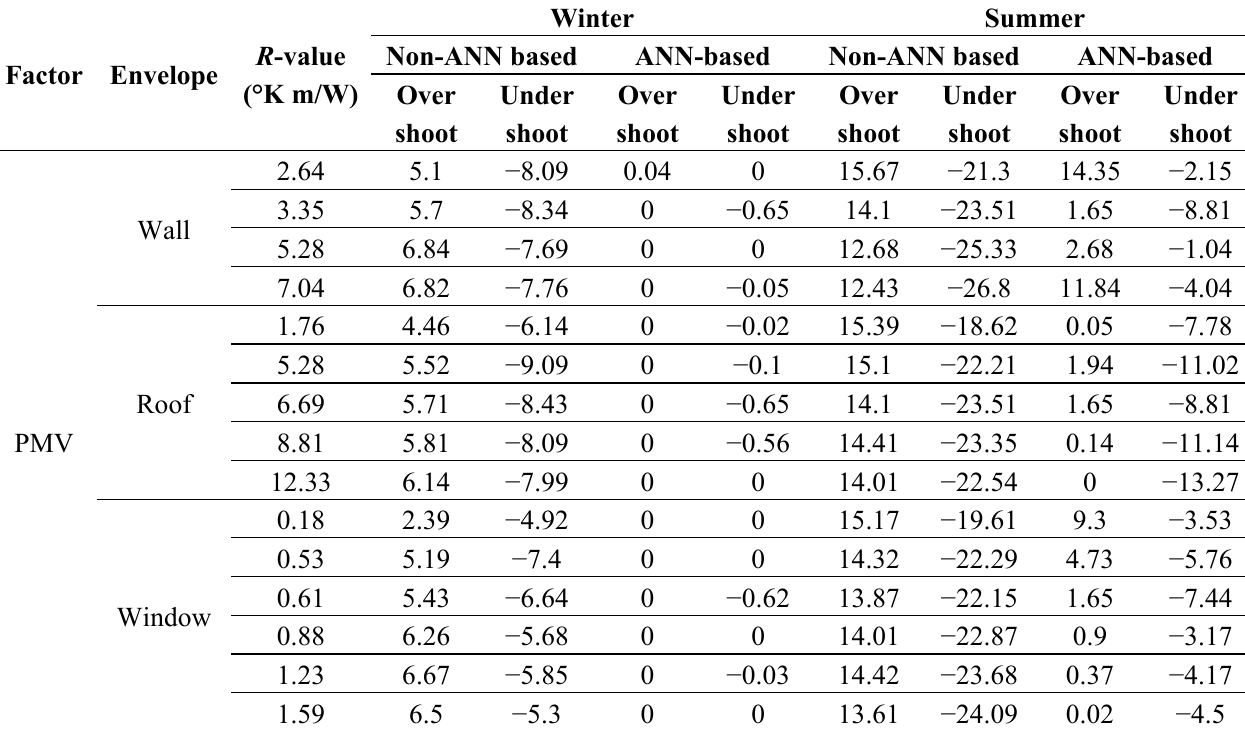
Table 10. Magnitude of overshoots and undershoots of PMV based on envelope insulation.